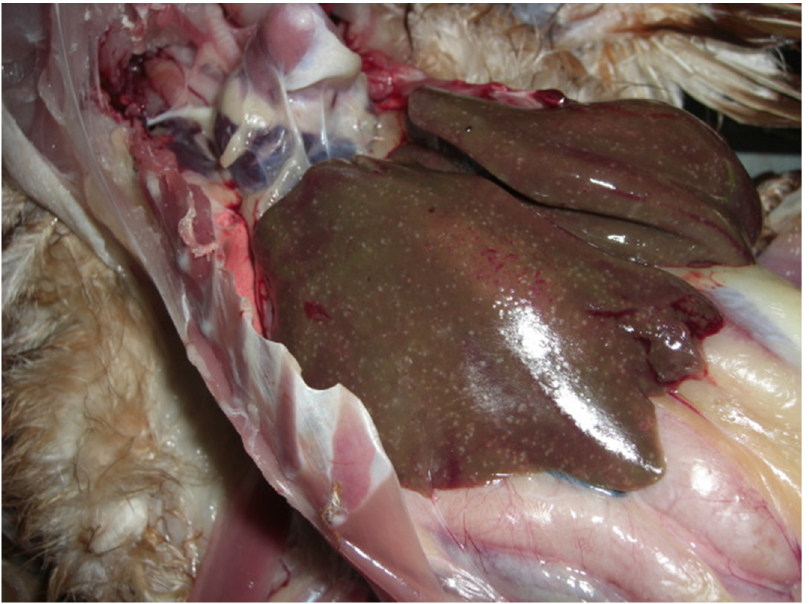
Figure 1. Illustrates liver with necrotic lesions characteristic of spotty liver disease (SLD) in chickens. (Photo courtesy, Dr Arif Anwar, Scolexia Pty Ltd., Moonee Ponds, VIC,